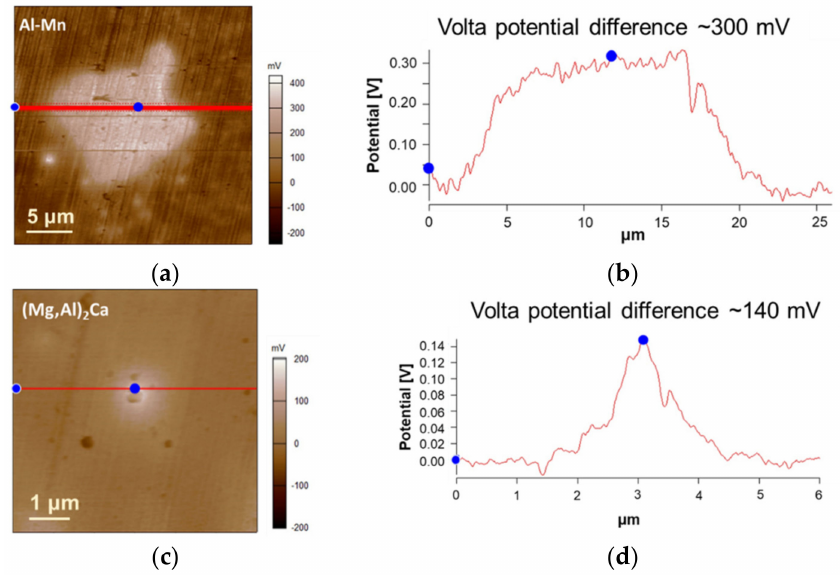
Figure 4. ( a , c ) Volta potential maps and ( b , d ) Volta potential line scans for the two second-phase particles: ( a , b ) Al–Mn; ( c , d ) (Mg, Al) 2 Ca.